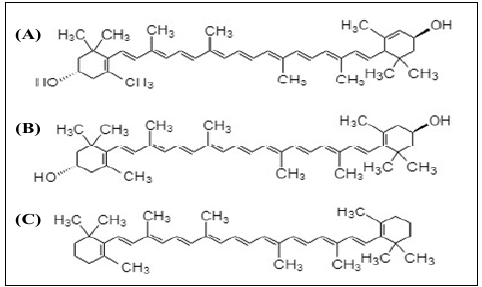
Figure 2. Chemical structures of ( A ) lutein, (B ) zeaxanthin, and ( C ) β -carotene.